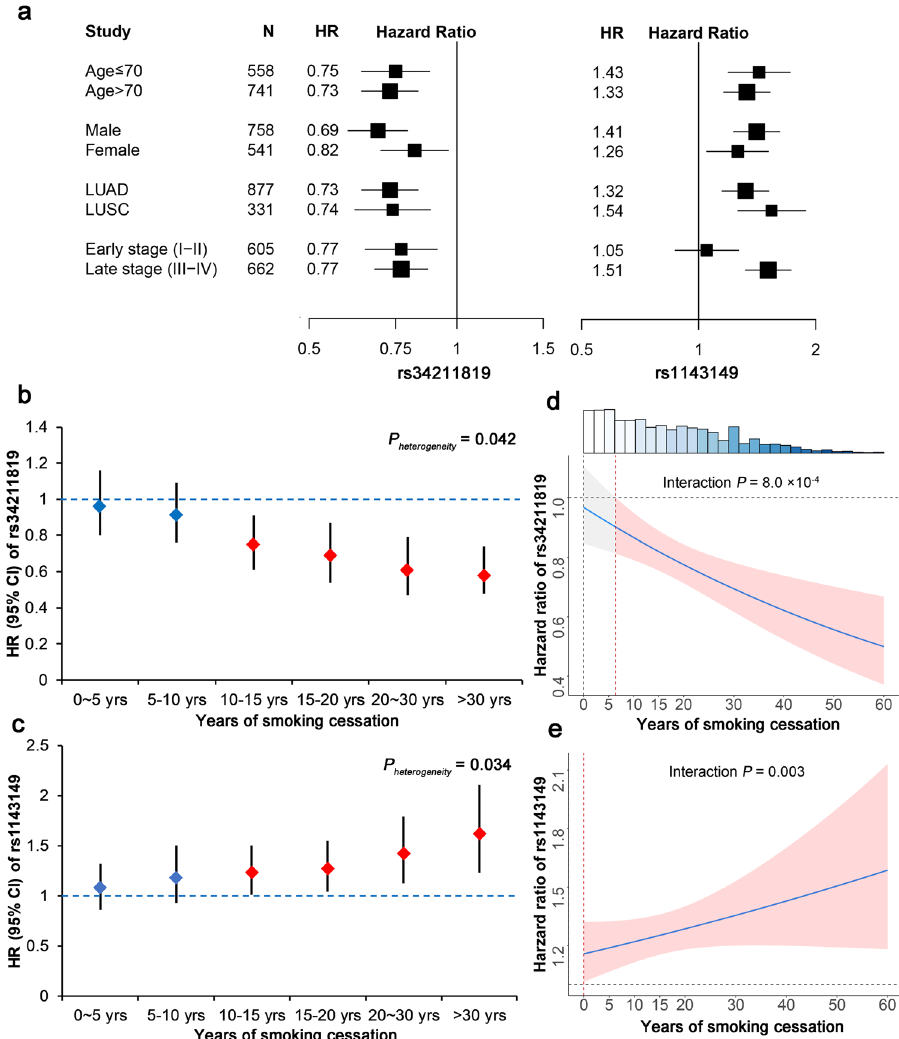
Fig. 2 Strati fi ed analysis and interaction analysis with smoking cessation years. a Strati fi ed analysis of rs34211819 (left) and rs1143149 (right) among different subgroups of long-term former smokers by age (divided by median value), gender, histology type, and clinical stage. b, c Strati fi ed analysis of rs34211819 and rs1143149 by different years of smoking cessation in overall NSCLC patients. The left-hand Y -axis shows the effect size (HR and 95% CI) derived from the Cox proportional hazards regression model. d, e Interaction plot for HRs of SNPs estimated based years of smoking cessation. The shaded area represents the 95% CI. Top histogram shows distribution of years of smoking